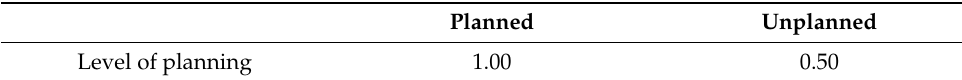
Table 5. Sample land price ratio table (level of